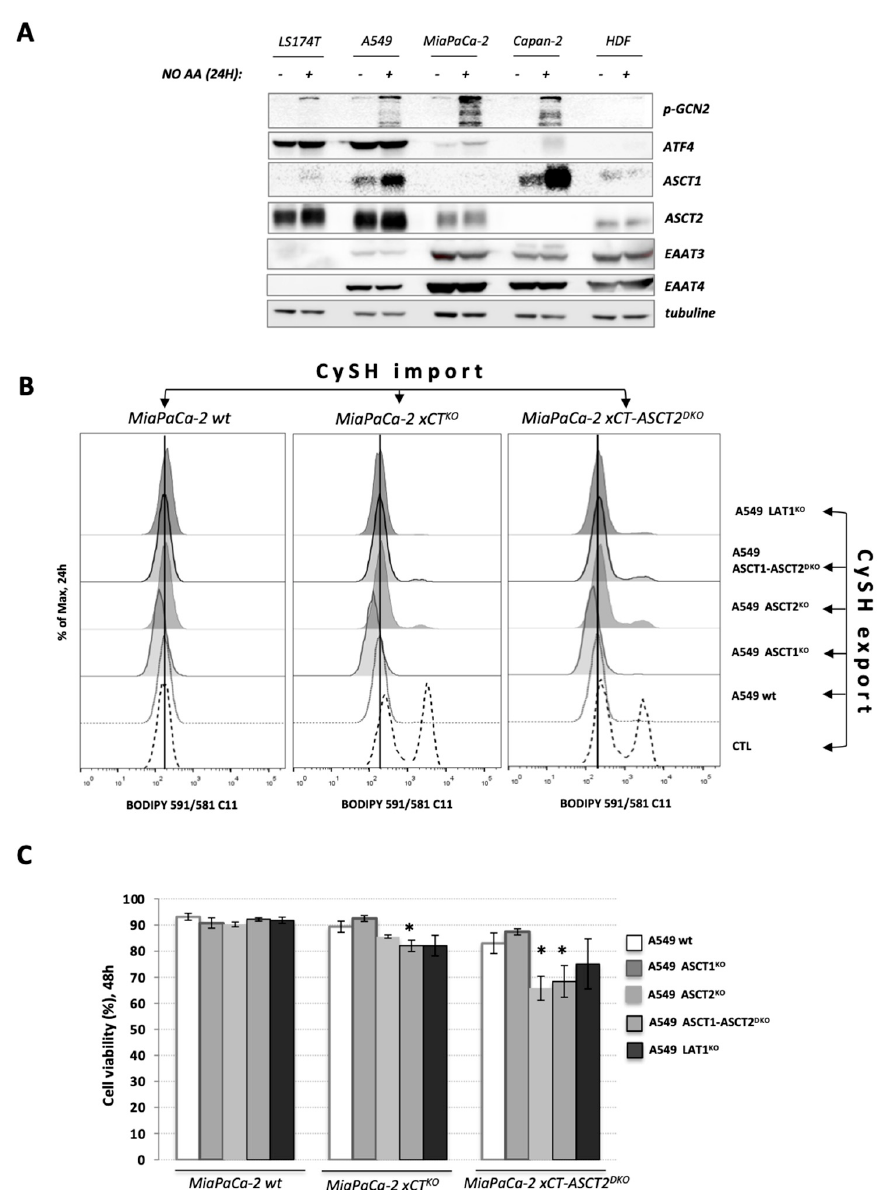
Figure 4. Genetic disruption of the ASCT2 cysteine transporter affects cooperation between xCT-expressing and xCT KO cells. ( A ). A variety of xCT wt cells (LS174T, A549, MiaPaCa-2, Capan-2 and HDF) were grown in DMEM media +/ − amino acids during 24 h and protein content of different cysteine transporters (ASCT1 (SLC1A4), ASCT2 (SLC1A5), EAAT3 (SLC1A1), EAAT4 (SLC1A6) were analyzed by Western blotting. ( B , C ). Lipid hydroperoxide accumulation and cell viability of MiaPaCa-2 xCT KO and xCT-ASCT2 DKO cells (guest cells—CySH import) in control conditions or co-cultured with 6% A549 wt, ASCT1 KO , ASCT2 KO , ASCT1-ASCT2 DKO , or LAT1 KO (host cells—CySH export). All experiments have been performed in triplicate and the representative blots and histograms are shown. Bar graph shows mean ± SEM; n = 3; *, p < 0.05, comparison with WT control